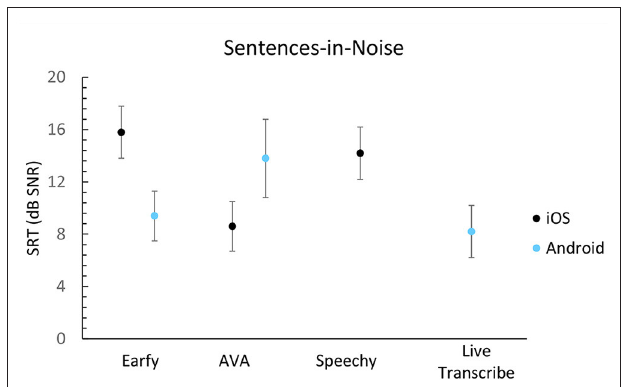
FIGURE 4 | Sentences in noise results expressed in SNR per app. A lower score is better. The error bars represent the standard deviation of the response of the app within a single list of sentences.